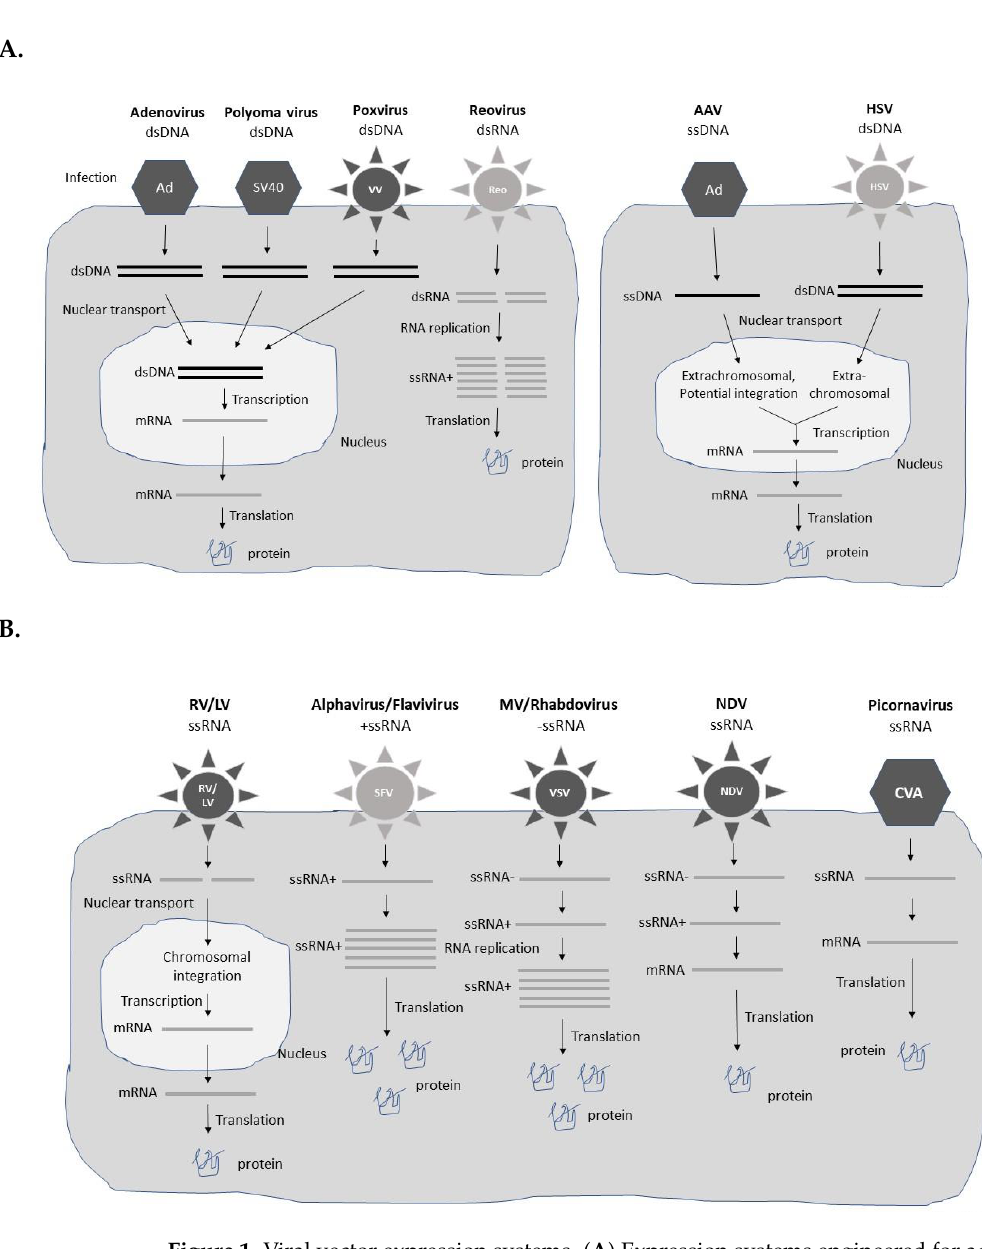
Figure 1. Viral vector expression systems. ( A ) Expression systems engineered for adenoviruses (Ad), simian virus 40 (SV40), vaccinia virus (VV), reoviruses, adeno-associated viruses (AAV), and herpes simplex viruses (HSV). ( B ) Viral vector systems for retro-and lentiviruses (RV), Semliki Forest virus (SFV), measles viruses and vesicular stomatitis virus (VSV), Newcastle disease virus (NDV), and coxsackieviruses A (CVA). dsDNA, double-stranded DNA, dsRNA, double-stranded RNA, ssDNA, single-stranded, DNA, ssRNA, single-stranded RNA, ssRNA+, ssRNA of positive polarity, ssRNA-, ssRNA of negative polarity.